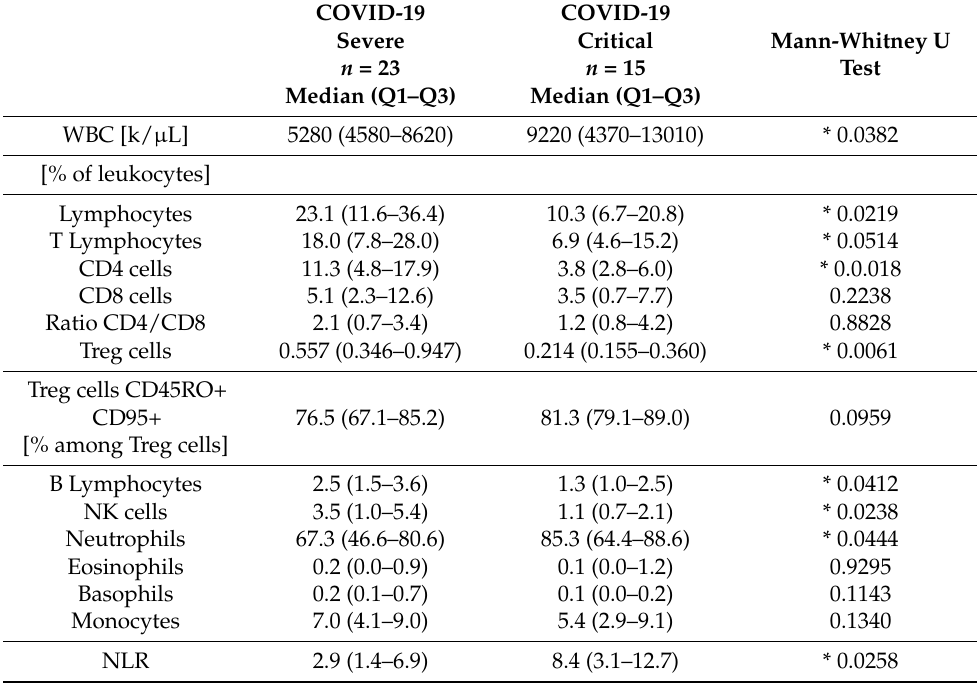
Table 2. Differences in the median of white blood cell (WBC) count, leukocytes and main lymphocytes subpopulation in patients with severe COVID-19 and critical COVID-19. Data expressed as median (Q1–Q3). * p <